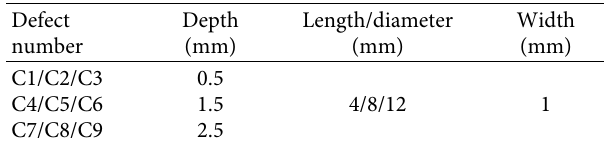
Figure 6: Schematic diagram of specimen and defects. Table 2: Defect parameters.